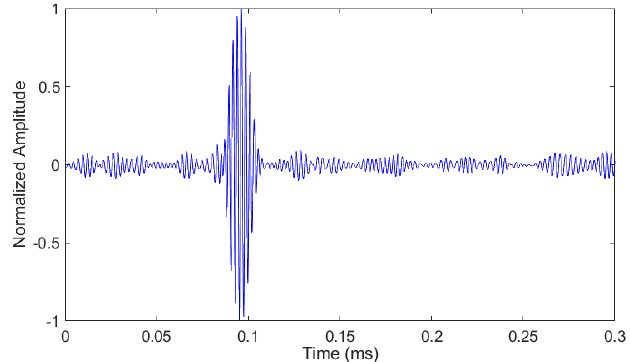
Figure 8. Time plot of an arbitrary atom from the experimental dictionary.